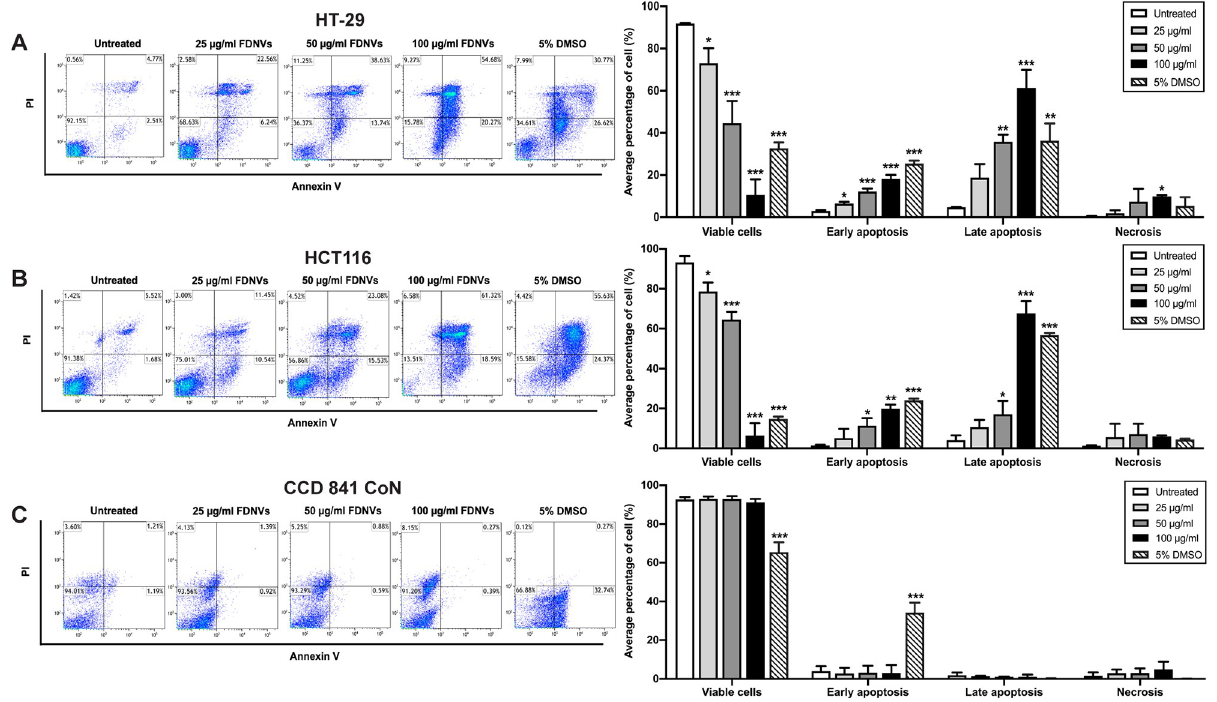
Fig 5. Representative FACS quantitative analyses showing FDNVs-induced apoptosis. (A) HT-29, (B) HCT116, and (C) CCD 841 CoN cells were treated with FDNVs at indicated concentrations for 48 h. The apoptosis induction of FDNVs-treated cells was examined using flow cytometry-based Annexin V staining. Data were analyzed using Kaluza analysis software and shown as means ± SD of three independent experiments in duplicate. � P < 0.05, �� P < 0.01 and ��� P < 0.001 (one-way ANOVA).